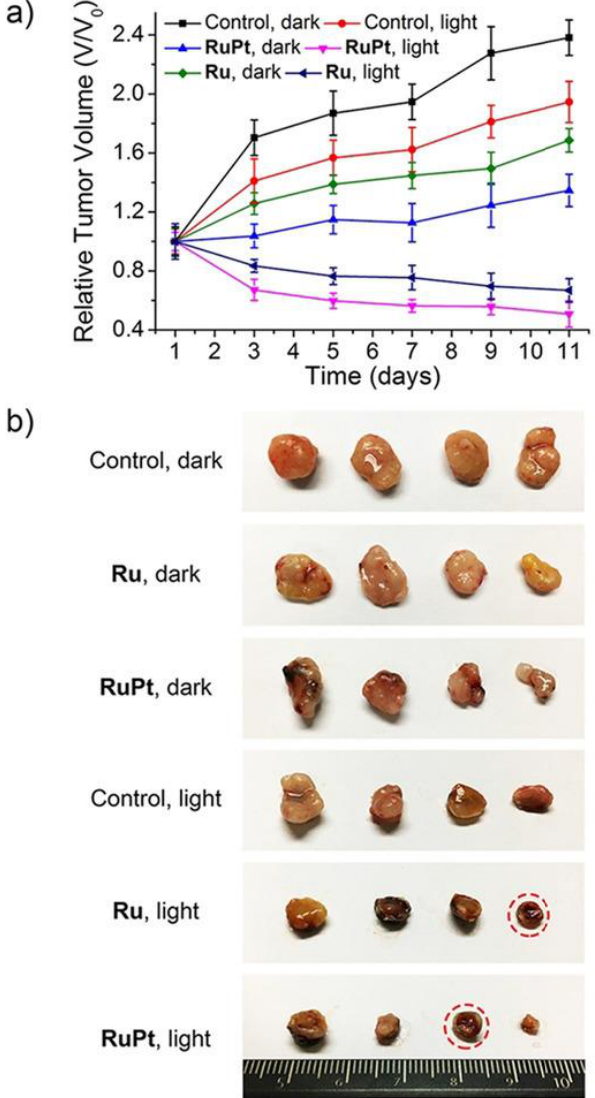
Figure 4. ( a ) Chart of the relative tumour volumes (V/V 0 ) of mice treated with PBS, 4 (Ru), and 5 (RuPt), measured for 11 days after treatment with PBS (control), under dark and light conditions. On the first and sixth days, intratumoral injections were performed. ( b ) Photo of the tumours removed from the nude mice. The completed scavenged tumours have been underlined by red dotted circles. (Reprinted with permission from ref. [31]. Copyright 2018 John Wiley and Sons).